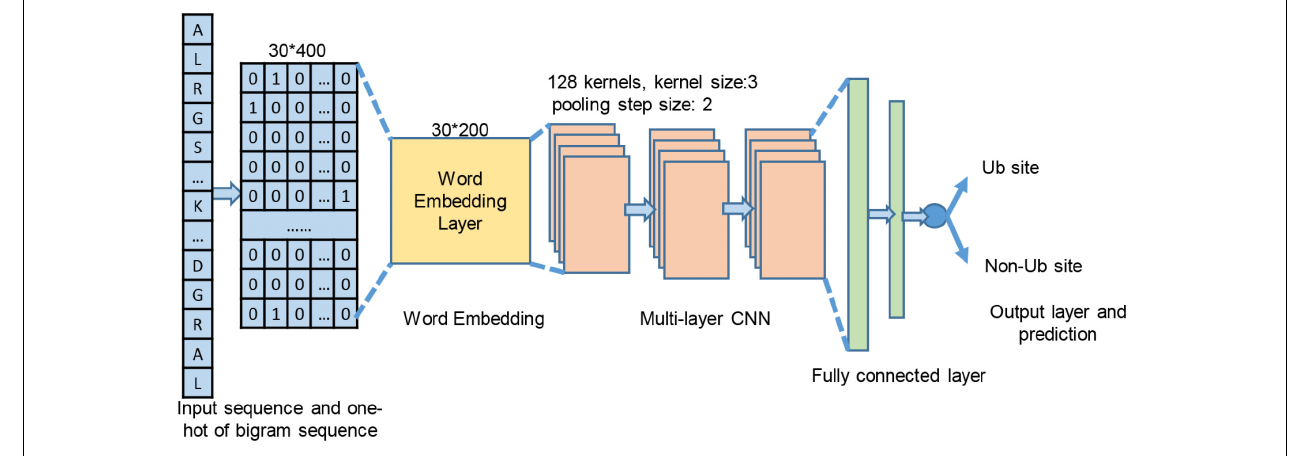
FIGURE 3 | Proposed deep structure for ubiquitination site prediction